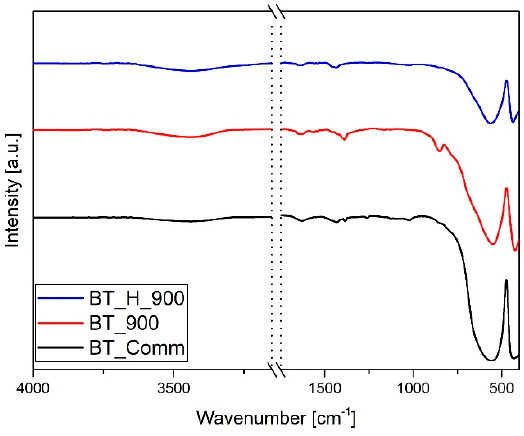
Figure 3. FTIR spectra of BT_comm, BT_900, and BT_H_900.